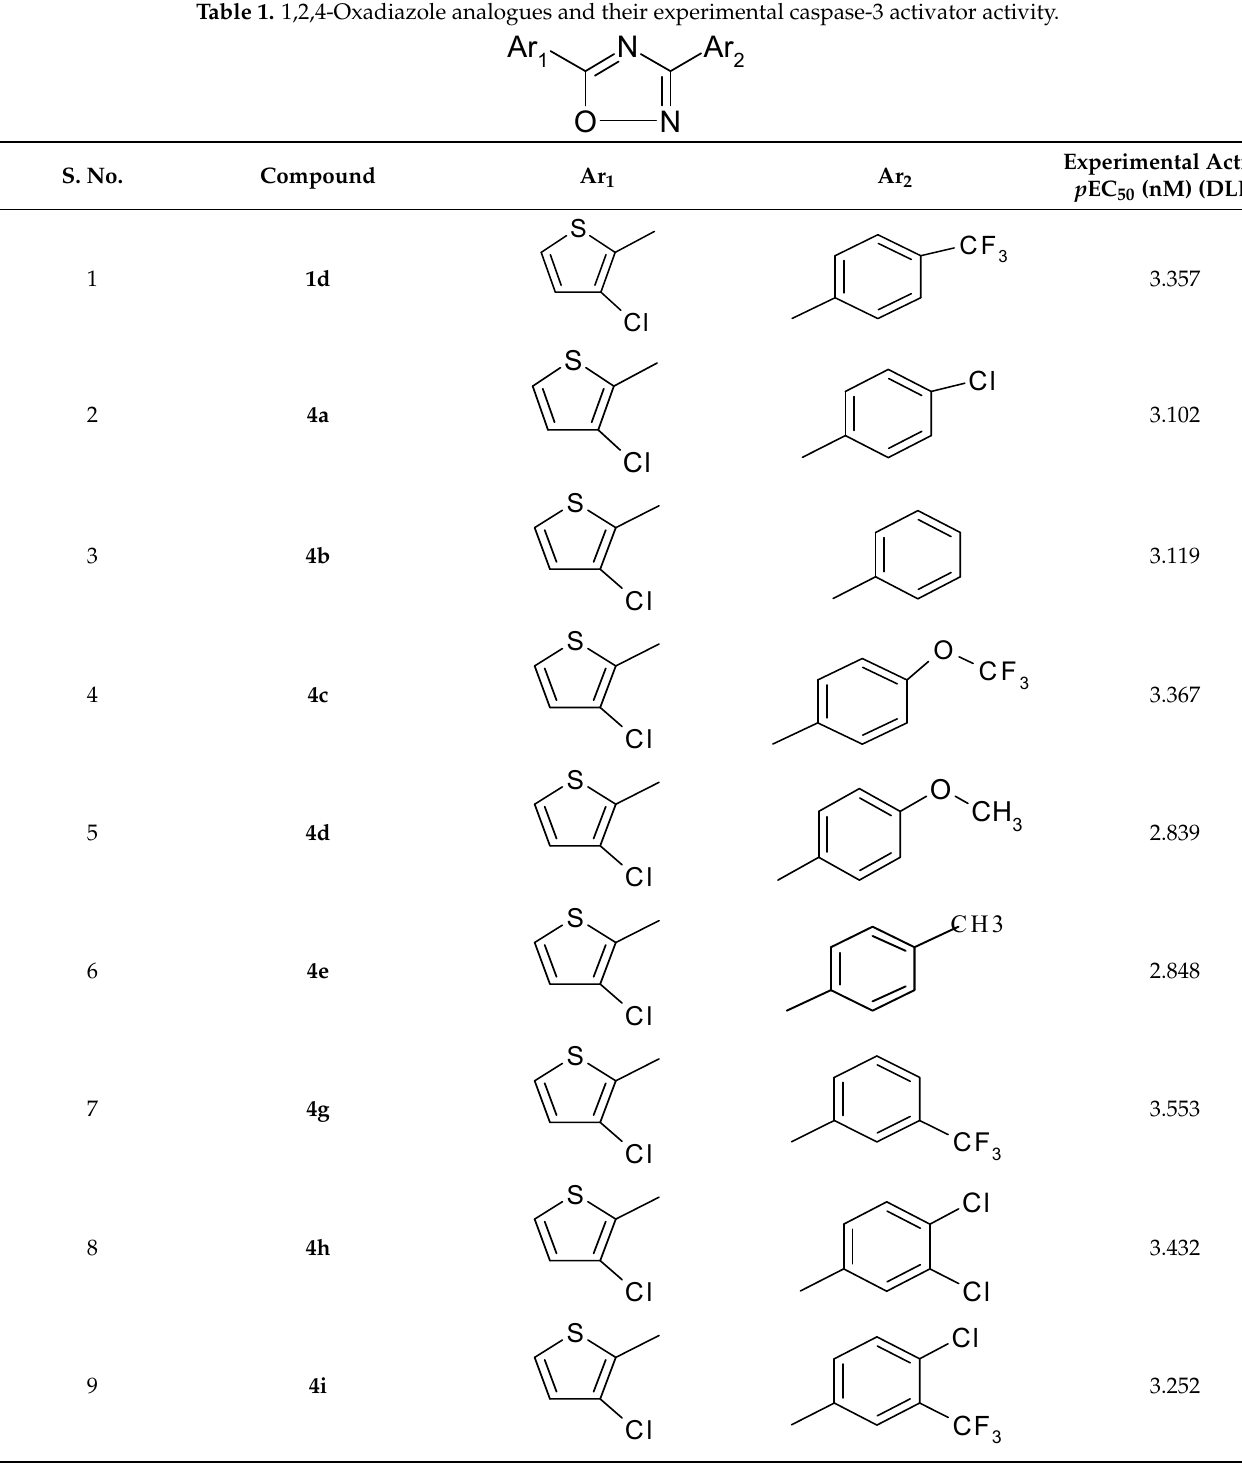
Table 1. 1,2,4-Oxadiazole analogues and their experimental caspase-3 activator activity.